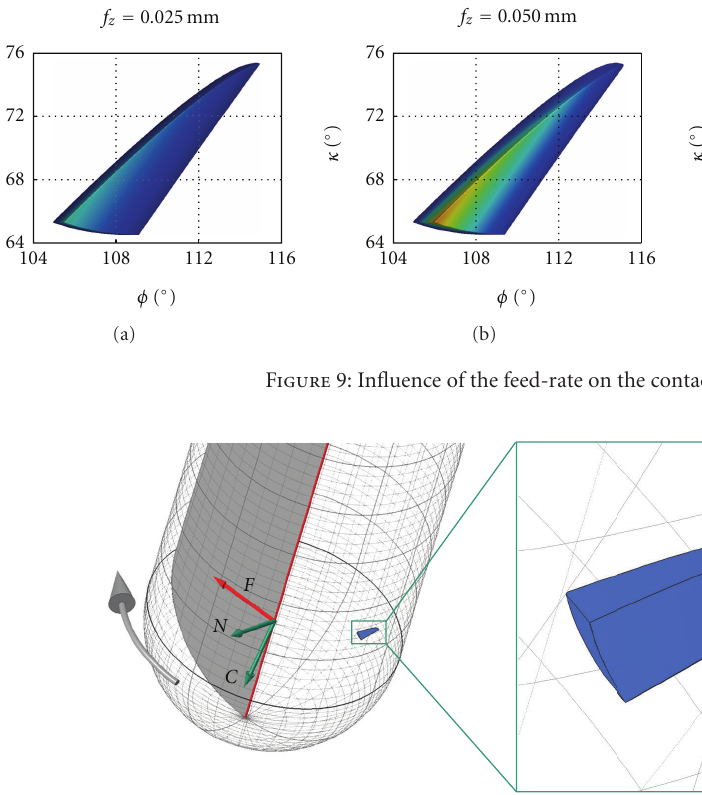
Figure 10: Chip position on ball-end mill for the simulation